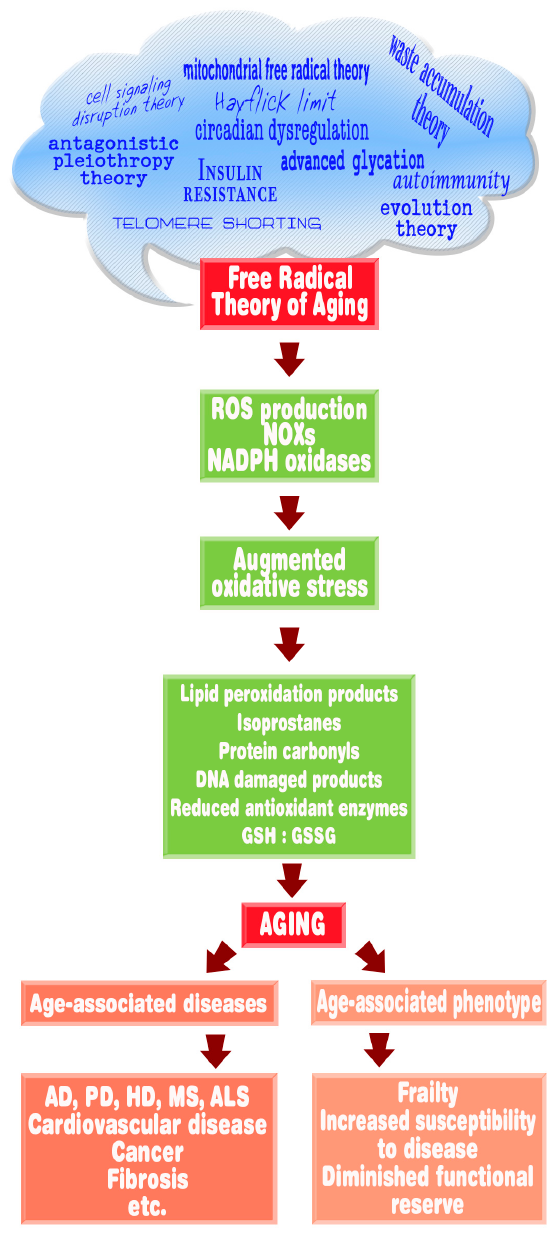
Figure 6. This figure is a flow diagram that links free radicals and the associated oxidative